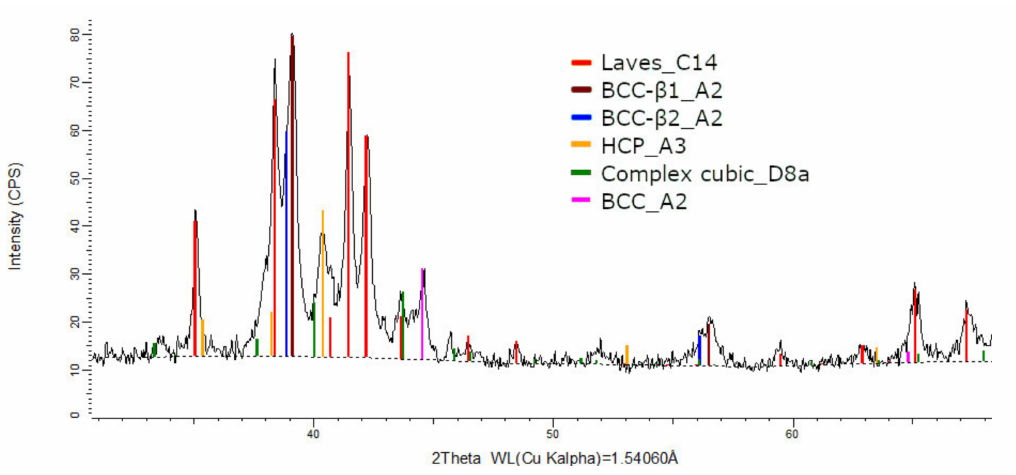
Figure 13. X-ray diffraction pattern for the FeTa 0.5 Nb 0.5 Ti 1.5 Zr 0.5 alloy.